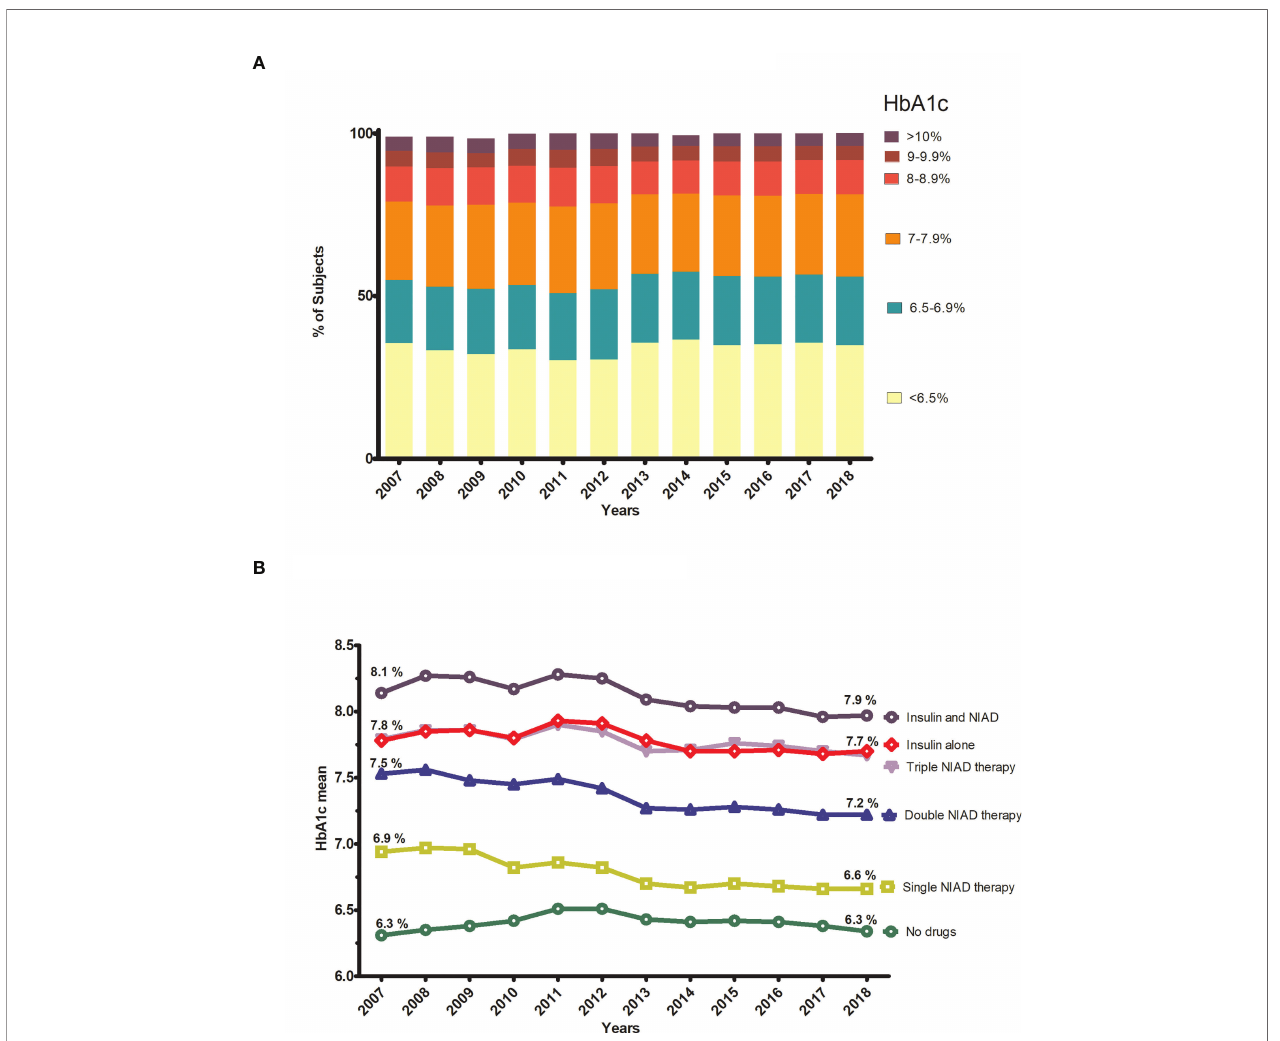
FIGURE 2 | Trends in glycemic control by HbA1c categories and by step of treatment. (A) Annual trends in distribution of subjects according to HbA1c categories. (B) Annual trends in the mean HbA1c for each step of